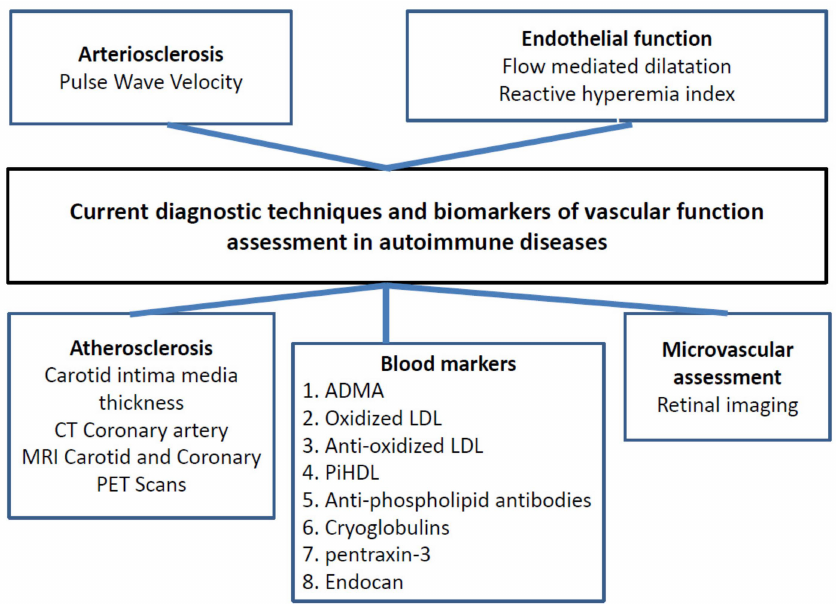
Figure 4. Overview of diagnostic techniques and biomarkers that are currently used in autoimmune rheumatic disease. Legend: PiHDL: proinflammatory, high-density lipoprotein; LDL: low-density lipoprotein; ADMA: asymmetric dimethylarginine; PET scan: positron emission tomography scan; FMD: flow mediated dilation; CT Scan: computerized tomography; MRI: magnetic resonance